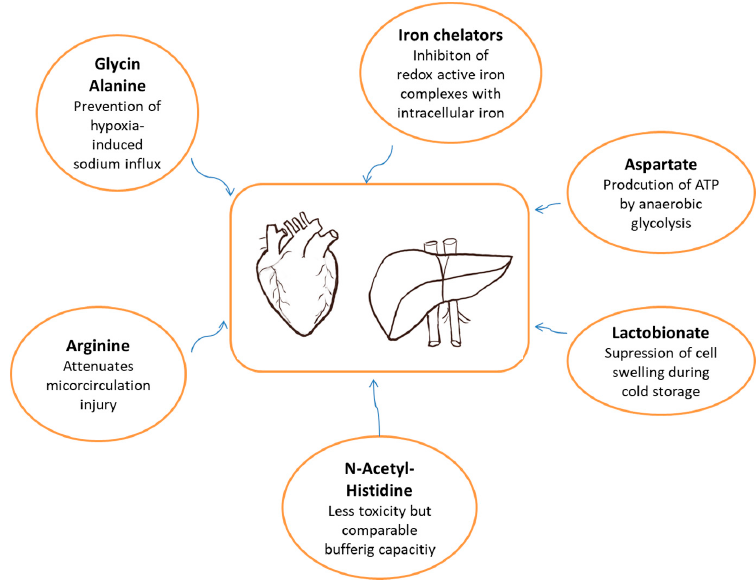
Figure 1. HTK-N and its site of actions on preserved organs.